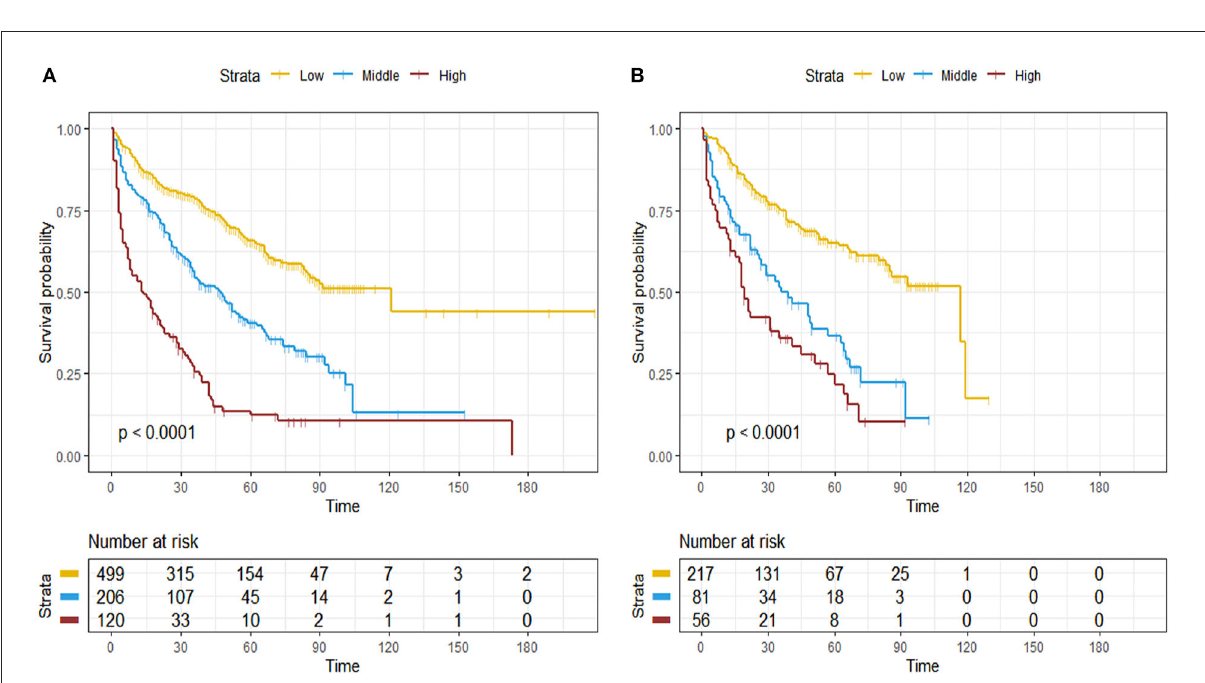
FIGURE5 Kaplan-Meier survival curves for the training set (A) and validation set (B)